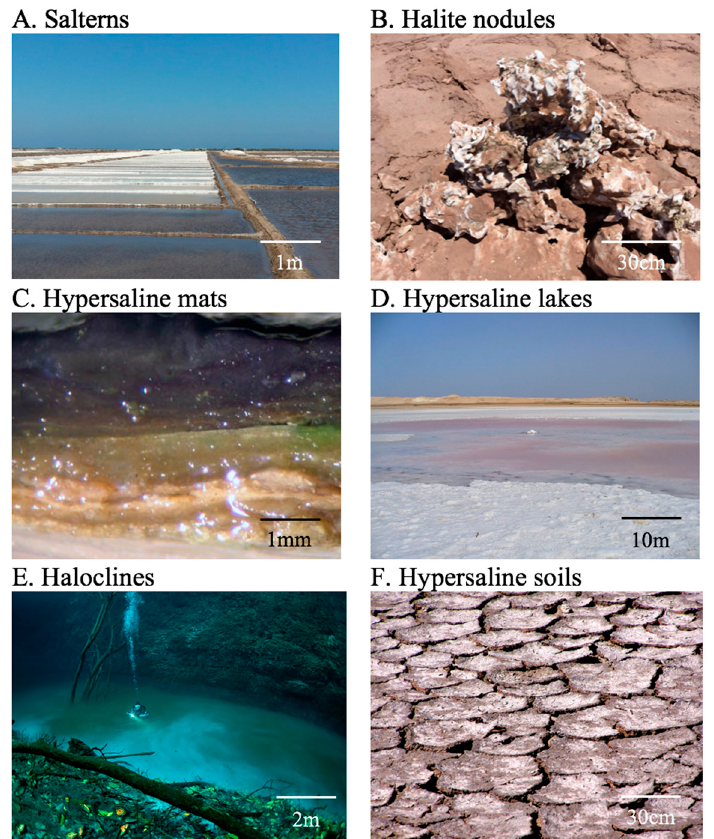
Figure 1. Photographs of commonly studied hypersaline environments: ( A ) saltern flats, ( B ) halite nodules, ( C ) hypersaline microbial mats, ( D ) hypersaline lakes, ( E ) underwater haloclines, and ( F ) hypersaline soils. * Sources for images (free-to-use sources): https://commons.wikimedia.org/ wiki/File:Salterns,_salt_making_fields,_tamil_nadu_-_panoramio.jpg, https://en.wikipedia.org/wiki/ Phototrophic_biofilm#/media/File:Microbial_mat_section.jpg, https://commons.wikimedia.org/wiki/ File:Saline_Lake_at_Ras_Mohamed_National_Park.jpg, https://commons.wikimedia.org/wiki/File: Halocline.png,